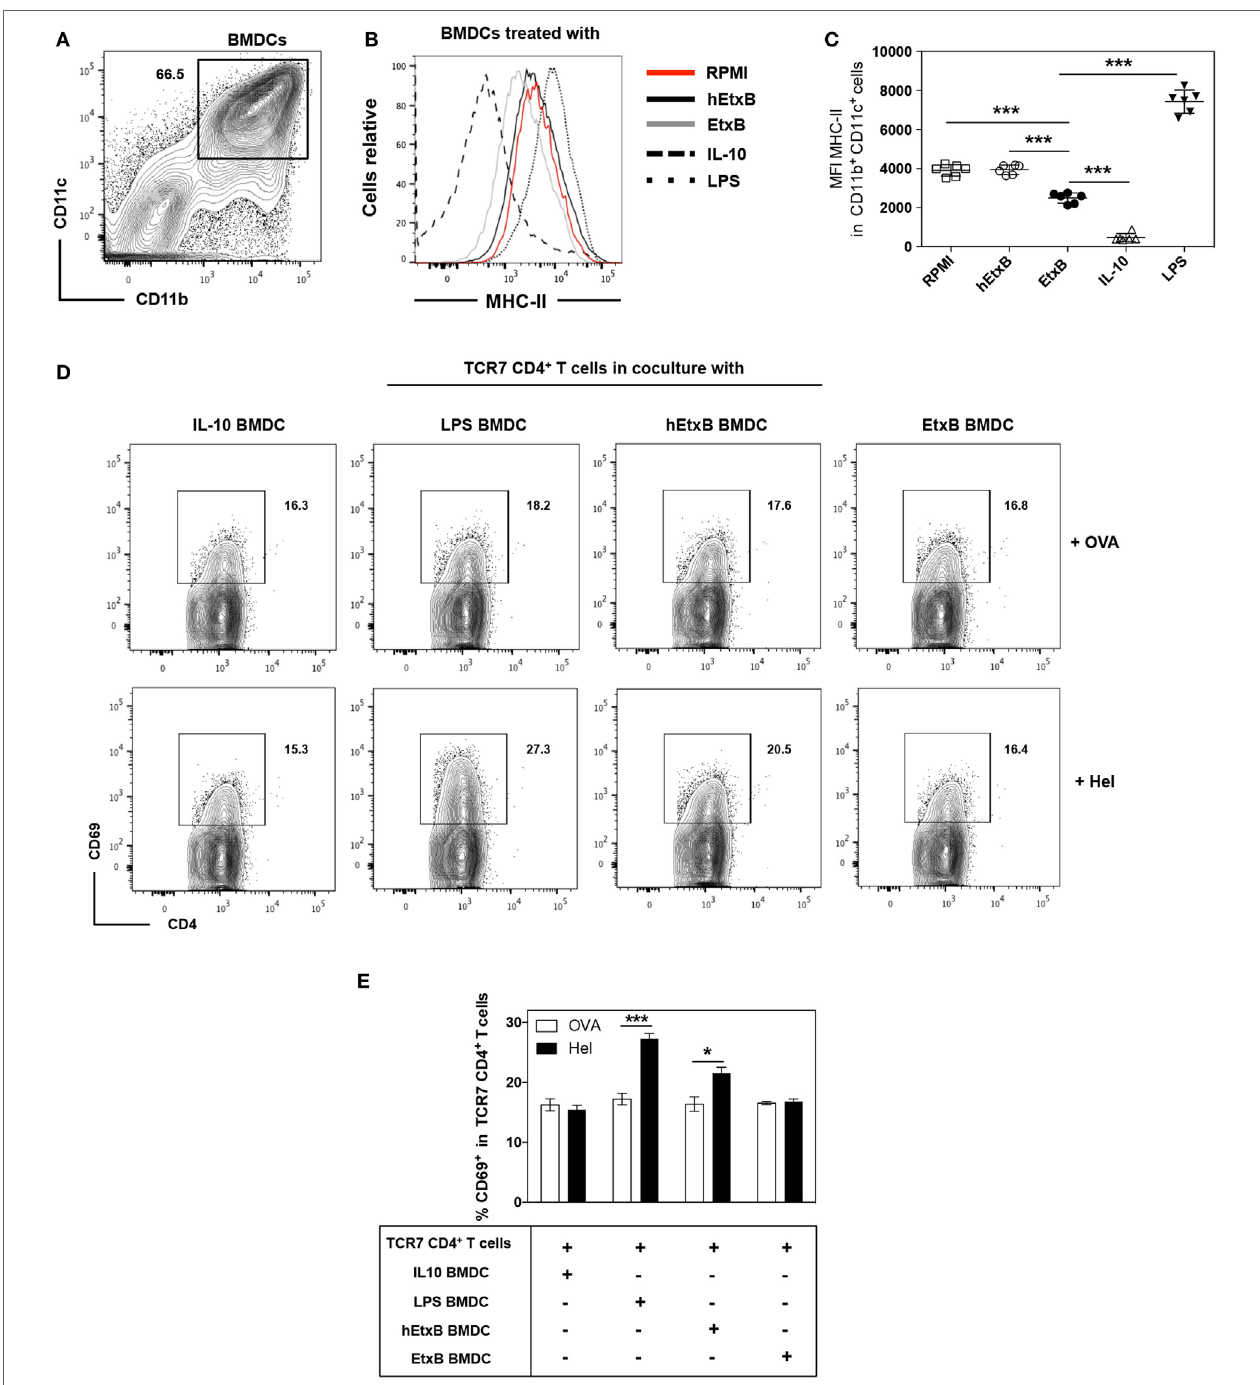
FigUre 5 | etxB inhibits the T cell activation capacity of bone marrow-derived dendritic cells (BMDcs) in vitro . BMDCs were induced by culturing bone marrow cells of C57BL/6 mice cultured with GM-CSF, IL-4 and 2-Mercaptoethanol for 6 days. (a) Flow cytometric contour plot of CD11b/CD11c expression on BMDC cultures. (B,c) Membrane expression of major histocompatibility complex (MHC) class II on BMDC cultures from different conditions as indicated, BMDCs were defined as CD11b + CD11c + cells. (D) Flow cytometric contour plots and bar chart (e) of CD69 expression on naïve TCR7 CD4 + T cells co-cultured with BMDCs generated under the indicated conditions, pulsed with either hen egg lysozyme (HEL) or ovalbumin (OVA) protein and then fixed. In dot plots, the mean and SD are represented and each symbol represents a technical replicate: white squares RPMI only treated cells, white circles hEtxB-treated cells, black circles EtxB-treated cells, white triangles interleukin-10 (IL-10)-induced tolerogenic BMDCs, black triangle lipopolysaccharide (LPS) treated BMDCs. In the bar chart, the height of the bar represents the mean; the error bars the SD. Results are from one experiment representative of three independent experiments. * p < 0.05 and *** p < 0.0005 (Mann–Whitney U